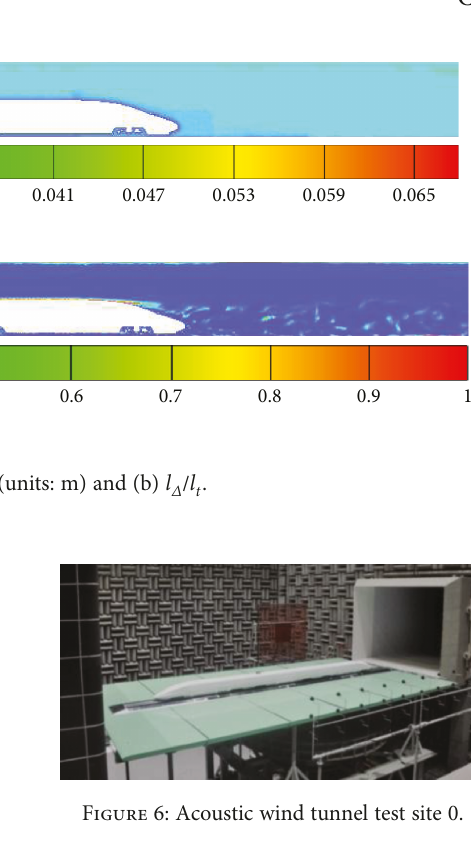
Figure 6: Acoustic wind tunnel test site 0.